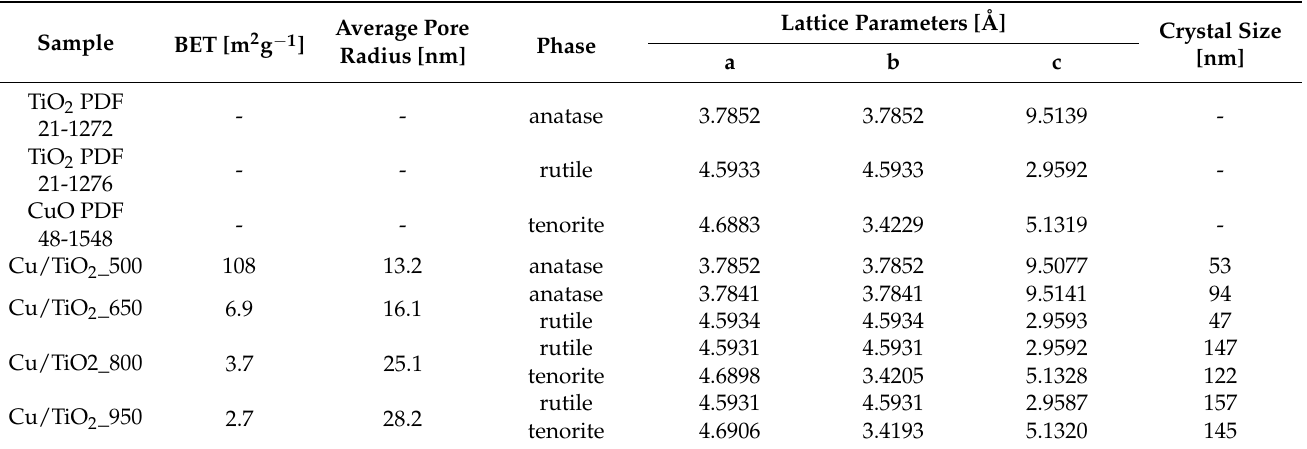
Table 1. Microstructural parameters of anatase, rutile, tenorite and samples Cu/TiO 2 _500, Cu/TiO 2 _650, Cu/TiO 2 _800 and Cu/TiO 2